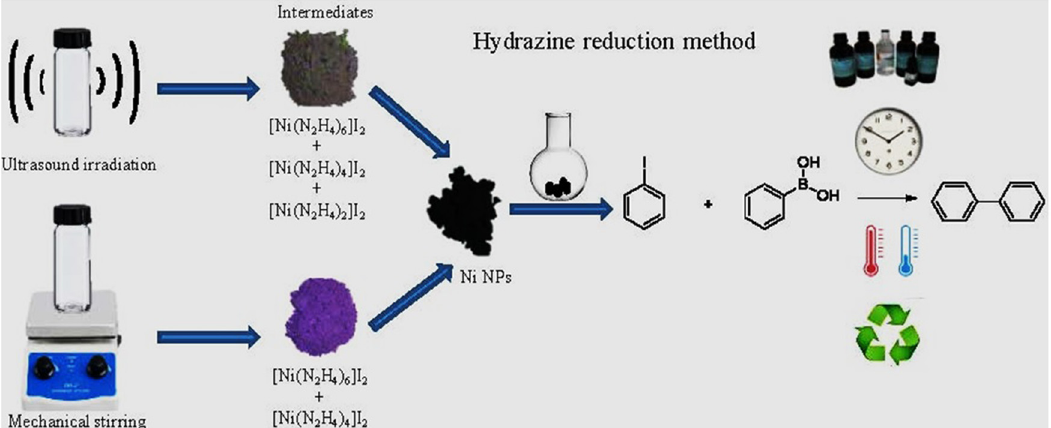
Figure 13: Illustration of the application of NiNPs in Suzuki - Miyaura cross - coupling reaction [ 164 ]